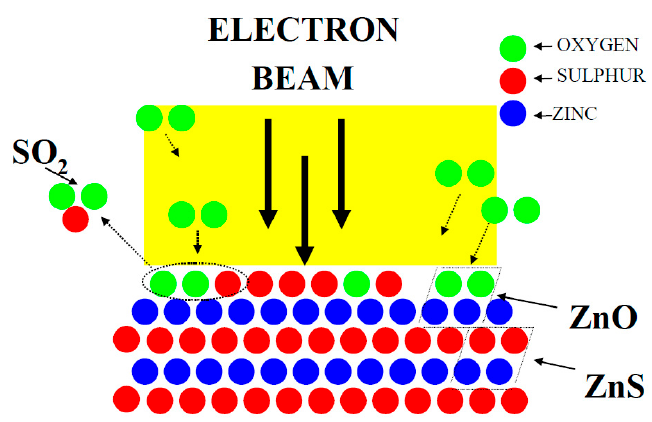
Figure 5. Schematic illustration of the ESSCR mechanism.